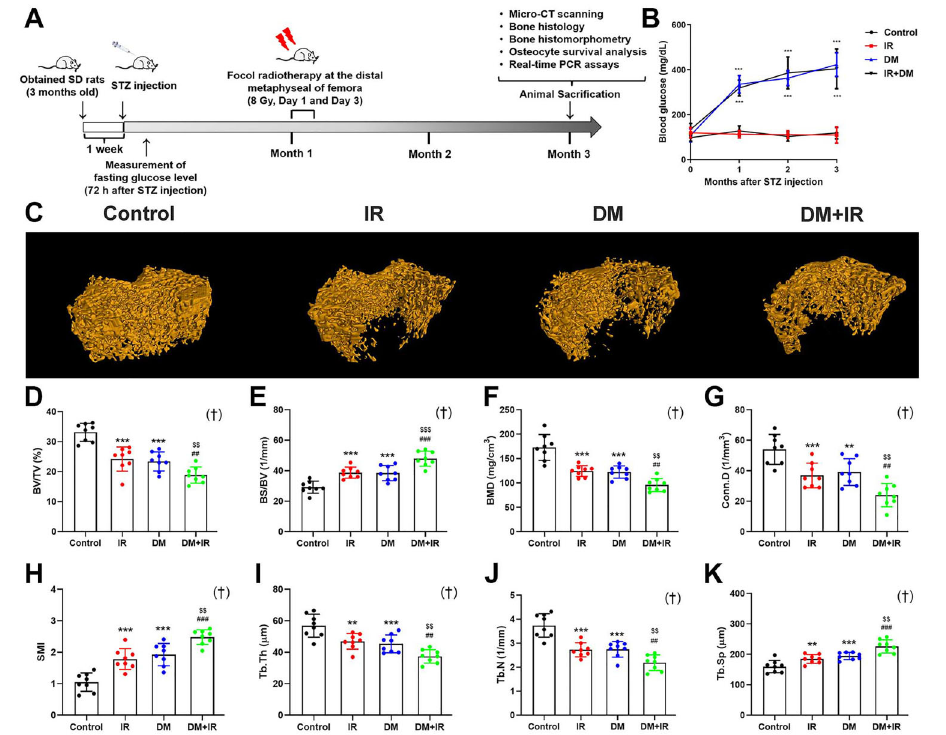
Figure 1. A , The schematic model of the present study. B , The fasting blood glucose levels of all rats in the four groups after streptozotocin (STZ) administration. C , Representative femoral trabecular bone micro-CT images selected from the volume of interests starting from the proximal end of the growth plate of distal femur and extending 2.5 mm to the proximal end in Control, irradiation (IR), diabetes mellitus (DM), and DM + IR rats. D – K , Quantitative analysis of micro-CT results, including bone volume/total volume (BV/TV), bone surface/bone volume (BS/BV), bone mineral density (BMD), connectivity density (Conn.D), structure model index (SMI), trabecular thickness (Tb.Th), trabecular number (Tb.N), and trabecular separation (Tb.Sp). Data are reported as means ± SD (n=8). **P o 0.01, ***P o 0.001 vs Control group; ## P o 0.01, ### P o 0.001 vs IR group; $$ P o 0.01, $$$ P o 0.001 vs DM group; w interactions between DM and IR